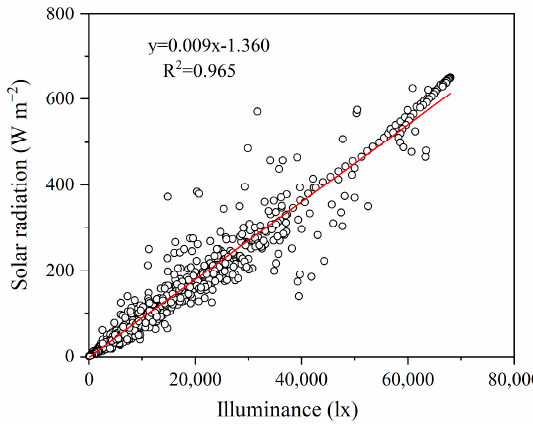
Figure 2. Relationship between solar radiation and illuminance data.